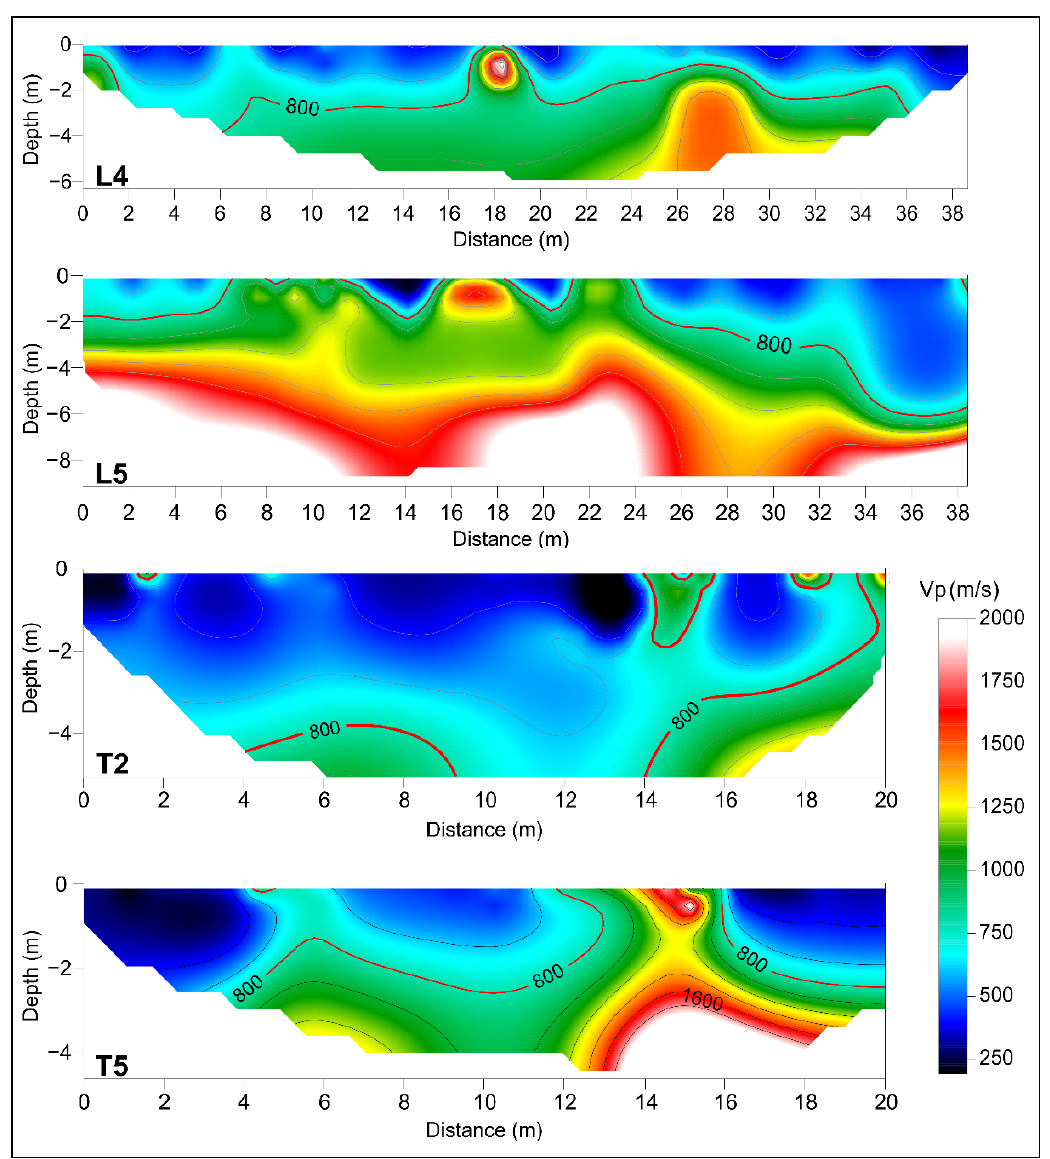
Figure 8. Examples of longitudinal (L) and transversal (T) seismic tomographies. The red line highlights the isoline related to V p = 800 m/s.